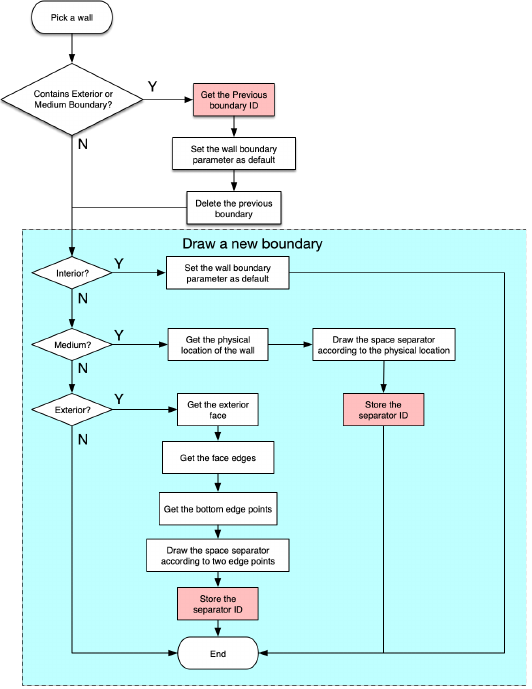
Figure 10. Creating the boundary flowchart version 1.1